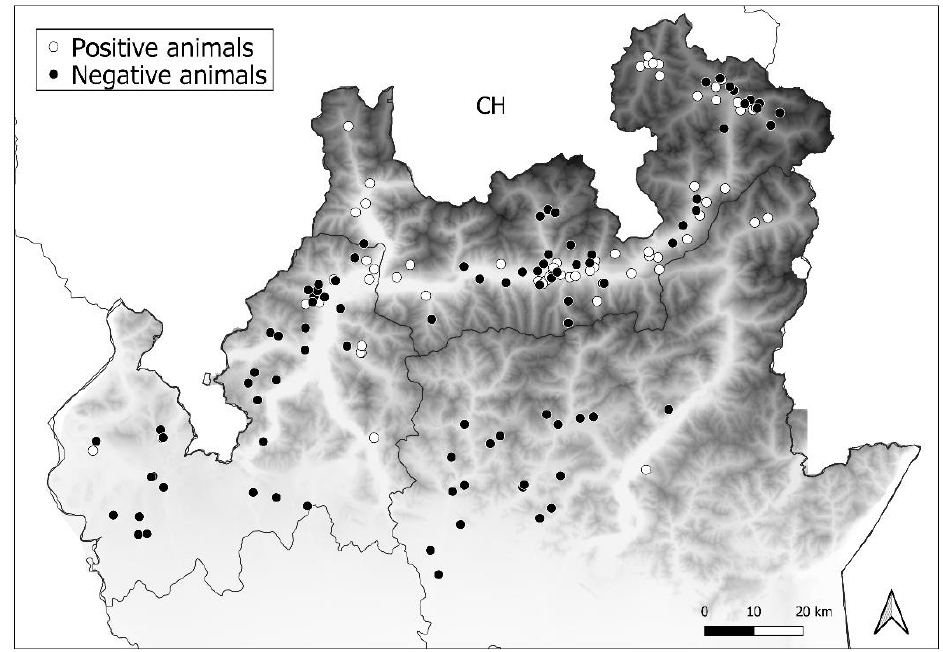
Figure 2. Distribution of positive ( white circles ) and negative animals ( black circles ) among the three study areas.